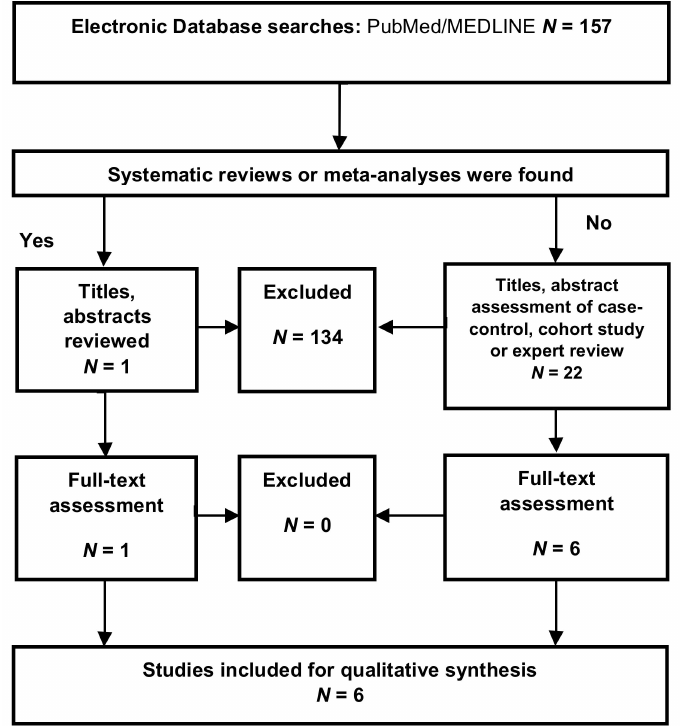
Figure A2. Flow diagram of qualitative synthesis regarding kynurenines in neurodegenerative diseases, adopted from Preferred Reporting Items for Systematic Reviews and Meta-Analyses